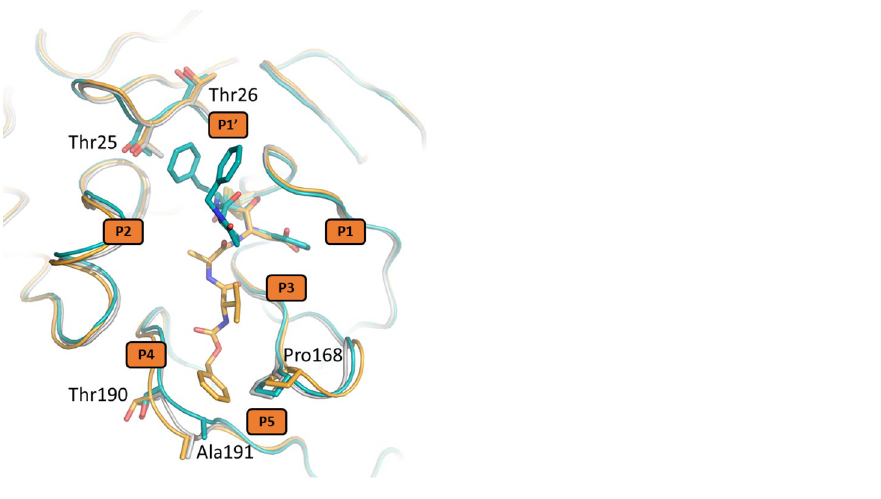
Figure 6. Flexibility induced in the active site of SARS-CoV-2 M pro by compounds 1 and 5 from the ReFRAME library. Grey–Ligand-free M pro (pdb 5r8t), teal–M pro in complex with 1 , orange–M pro in complex with 5 . Figure generated with PyMOL, The PyMOL Molecular Graphics System, Version 1.8.0.5 Schrödinger, LLC (https:// pymol.